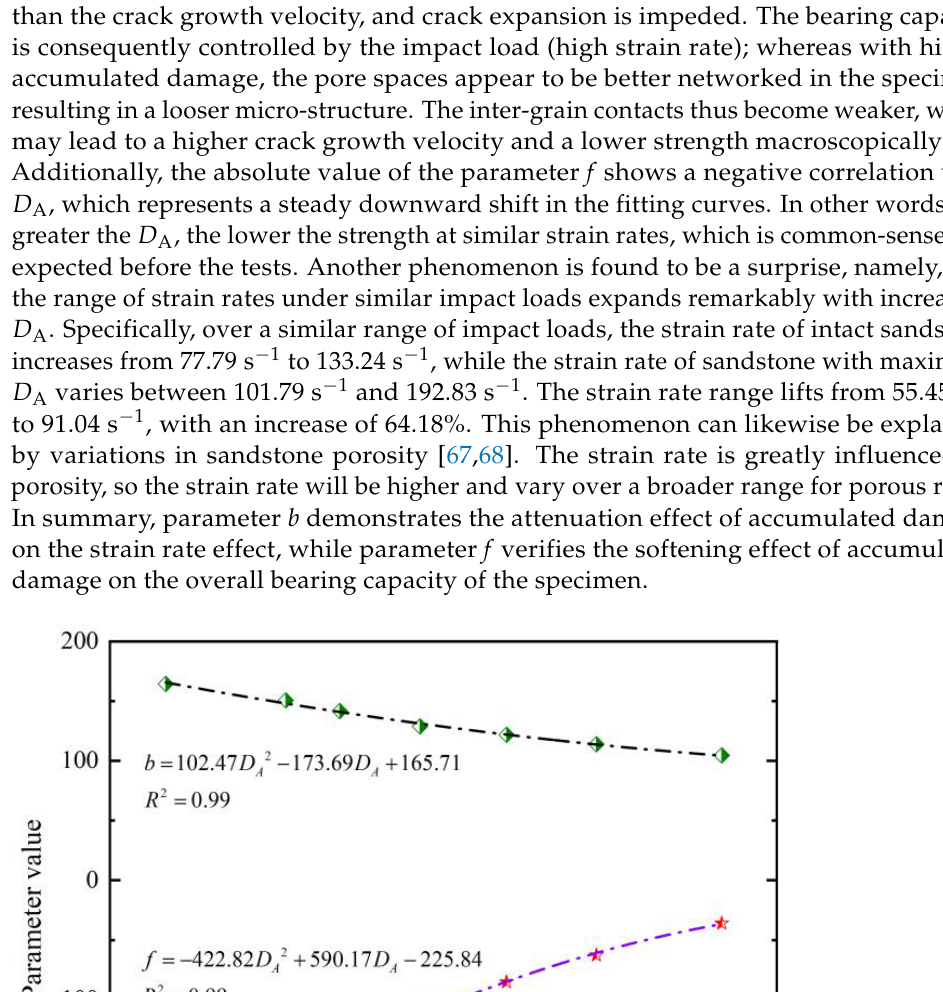
Figure 20. Variation of parameter b and f with